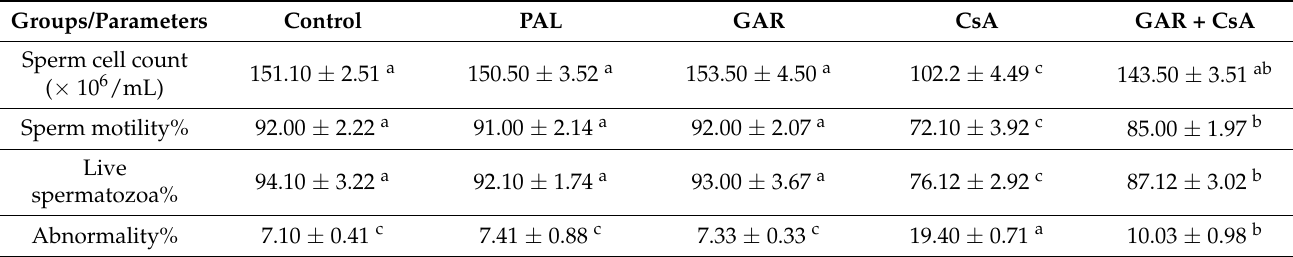
Table 5. Effect of treatment with Cyclosporine (CsA) and/or Garlic on semen analysis.